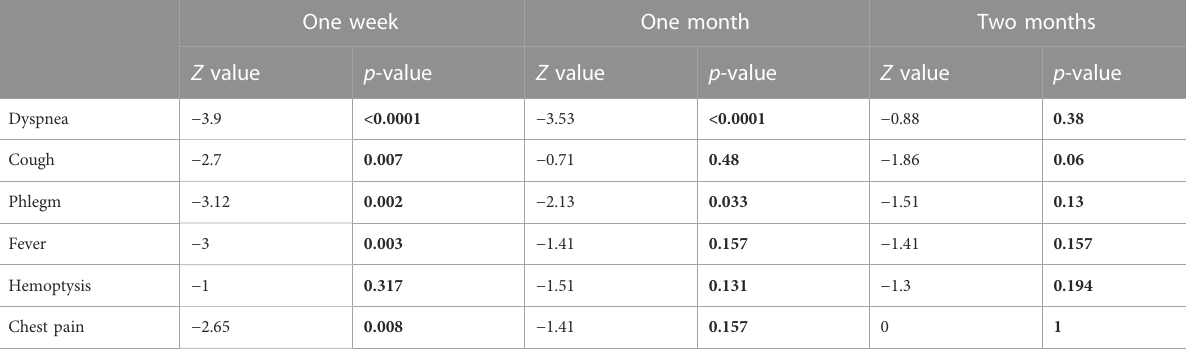
TABLE 4 Symptoms before and after